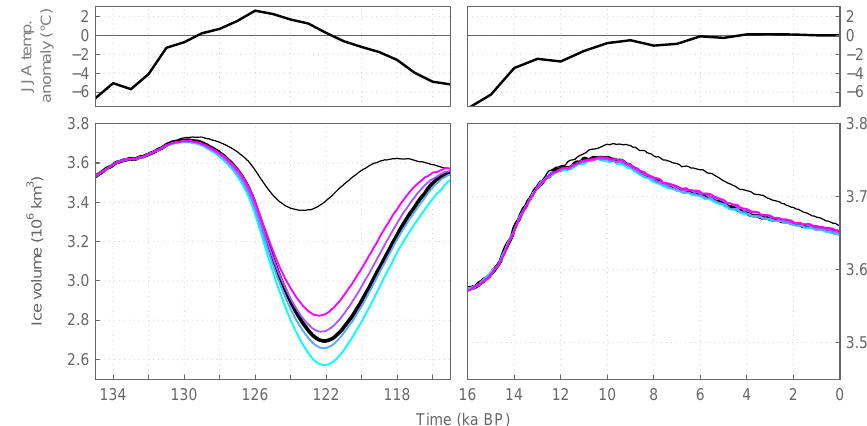
Figure 7. Transient simulations of the Eemian (left) and the Holocene (right) with a fully coupled climate–ice sheet model. Top: applied summer temperature anomaly forcing. Bottom: ice volume from simulations in which melt is calculated with the full model (thick black line), the reduced model forced with present-day insolation (thin black line) and an ensemble of insolation-corrected model versions with the parameter T min set to − 15, − 14, − 13 and − 12 ◦ C (values represented by cyan to magenta lines in the order